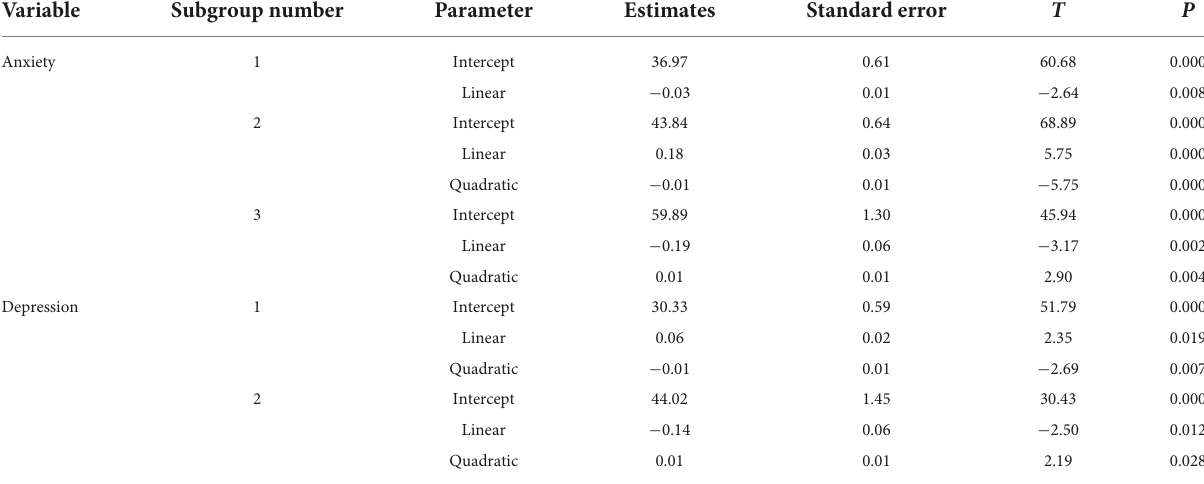
TABLE 3 The parameters of the optimal trajectory model among men who have sex with men (MSM).